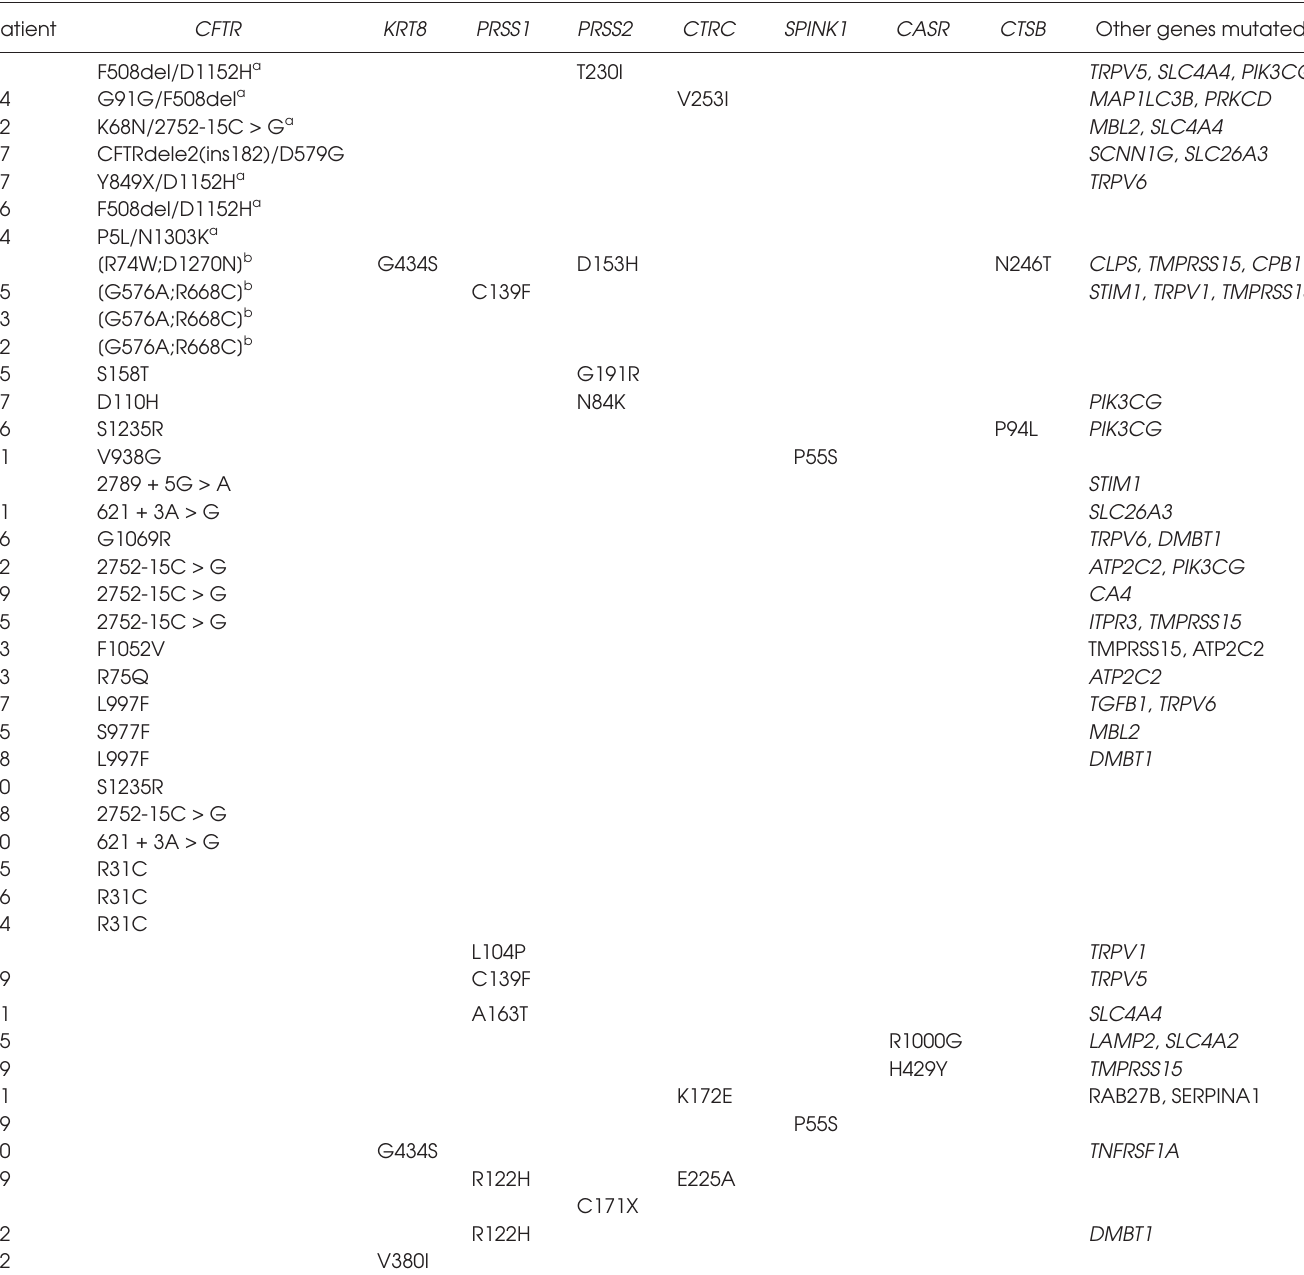
Table 4. List of patients with mutations in CFTR gene and variants in genes involved in the intrapancreatic activation of trypsin and of the other pancreatic pathways